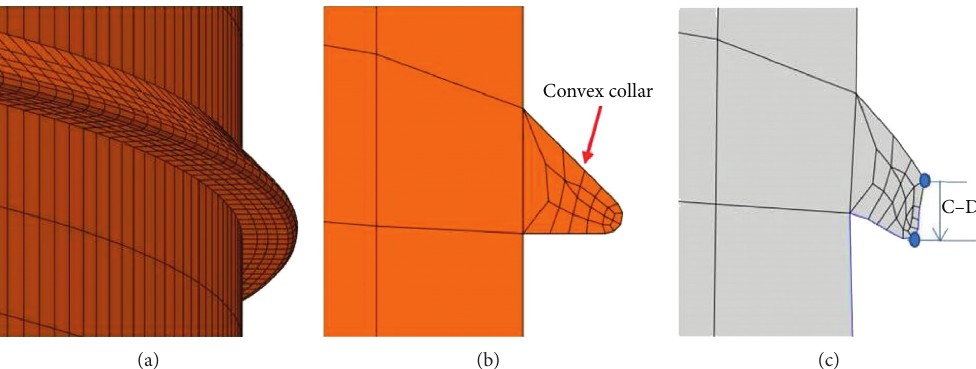
Figure 17: Metal convex collar grid and contact deformation diagram: (a) metal convex collar 3D diagram; (b) metal convex collar grid; (c) metal convex collar deformation diagram.